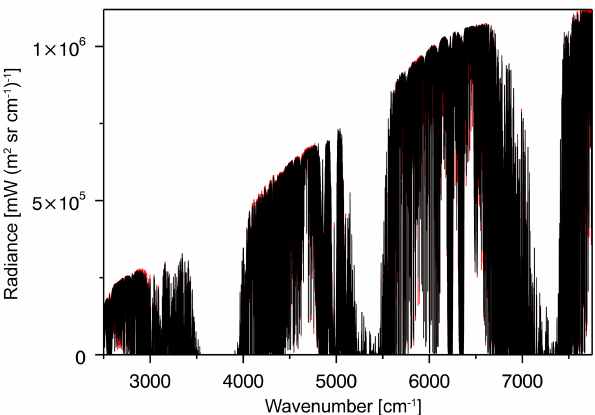
Figure 1. Mean measured (black) and synthetic (red) radiance spec- tra for the closure data set selected according to the criteria pre- sented in Sect.